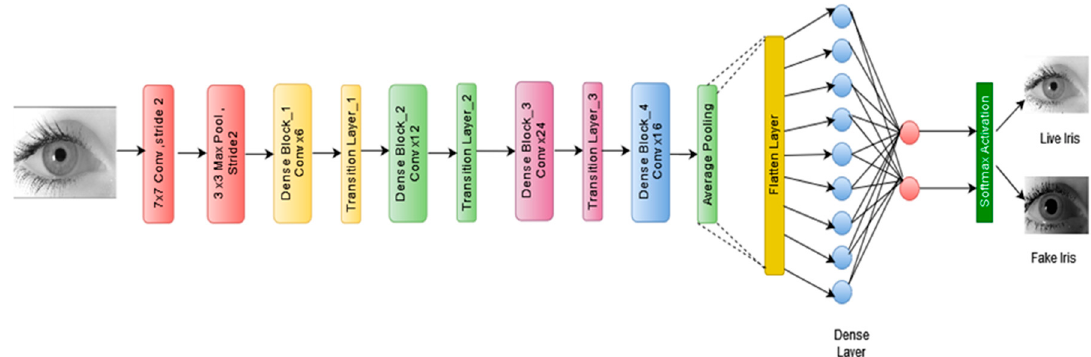
Figure 5. The DenseNet121 architecture, designed for iris liveness detection.